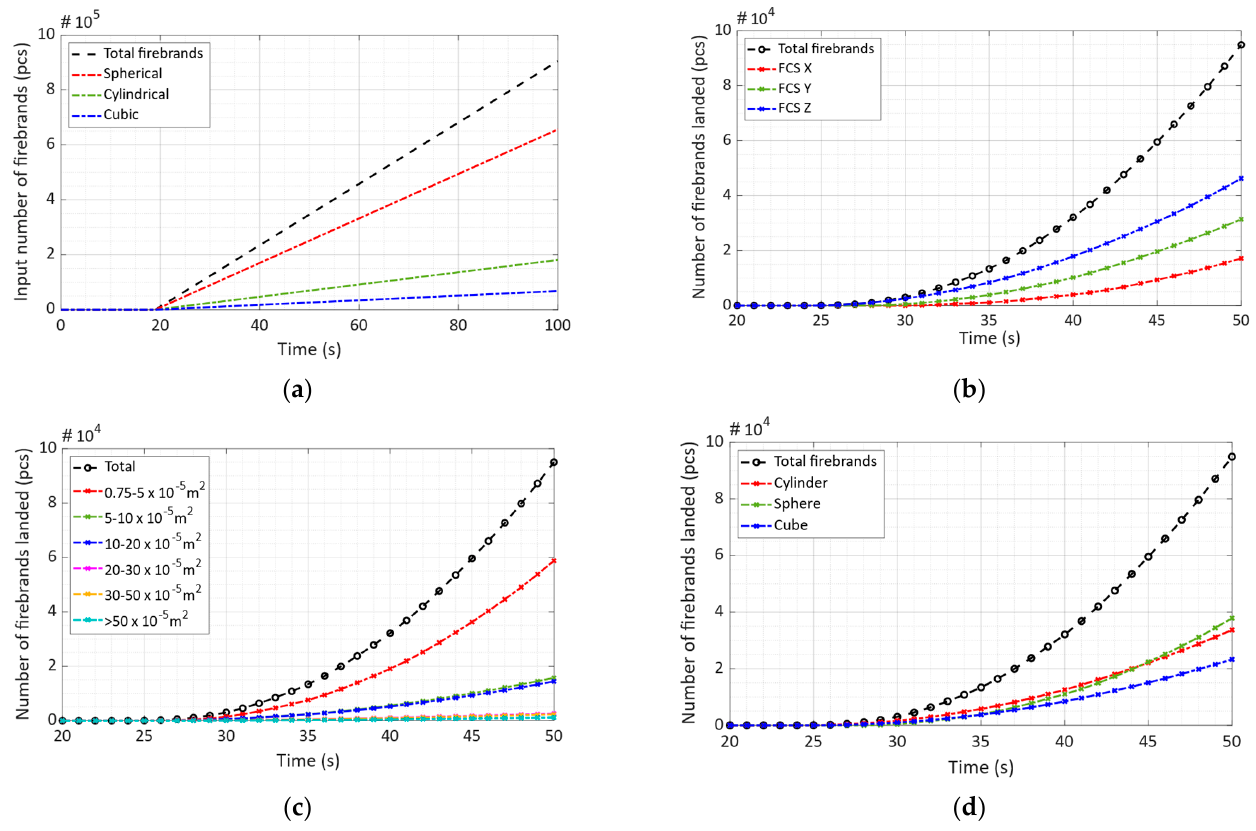
Figure 13. ( a ) The inputting/injecting number of firebrands against the time in terms of shapes and the total number. The injecting rate is kept constant. ( b – d ) The number of firebrands landed on the collection centers according to their landing locations, size classes, and shapes respectively. The landing rates of firebrands in these three representations are almost constant after some time (around 40 s).